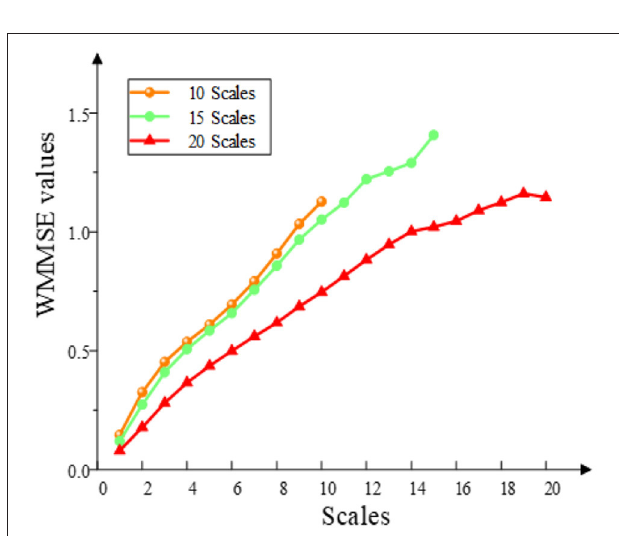
FIGURE 3 | Selection of WMMSE scales. The WMMSE values are calculated when the multiscale parameters are 10, 15, and